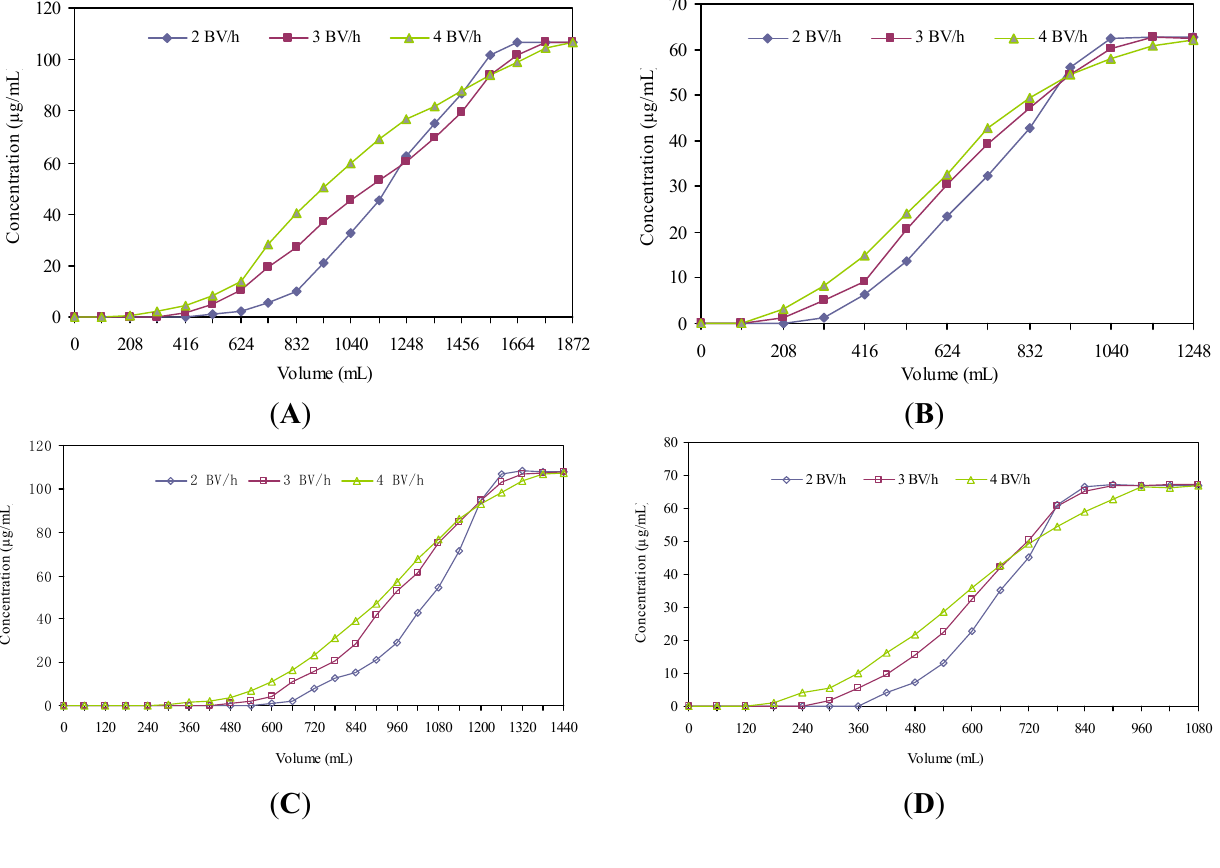
Figure 3. Dynamic breakthrough curves of ustiloxin A on the column packed with SP207 ( A ), ustiloxin B on the column packed with SP207 ( B ), ustiloxin A on the column packed with SP700 ( C ), and ustiloxin B on the column packed with SP700 ( D